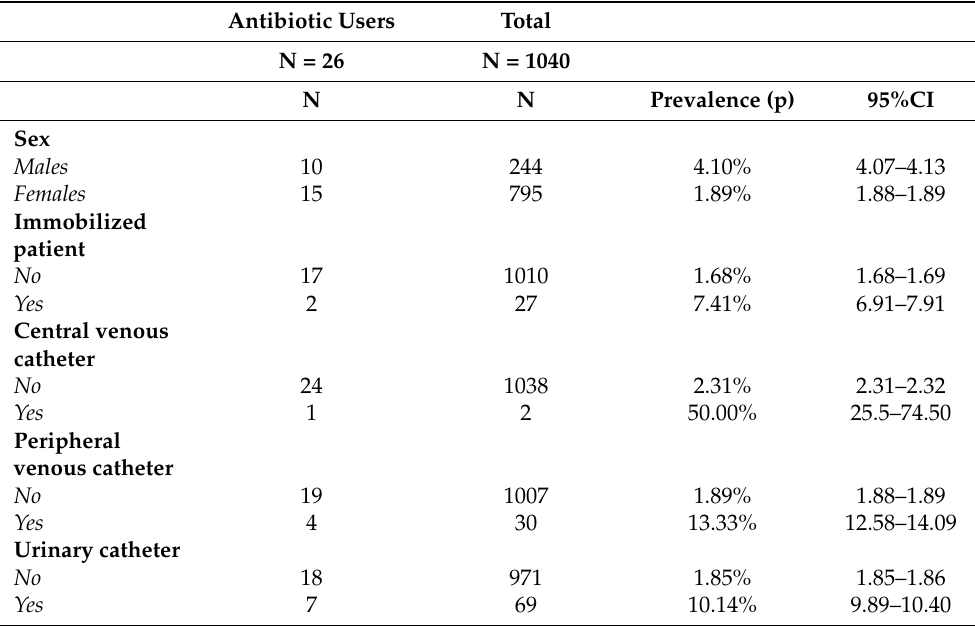
Table 4. Prevalence and corresponding confidence intervals for the association between the study covariables and antibiotic consumption in the study